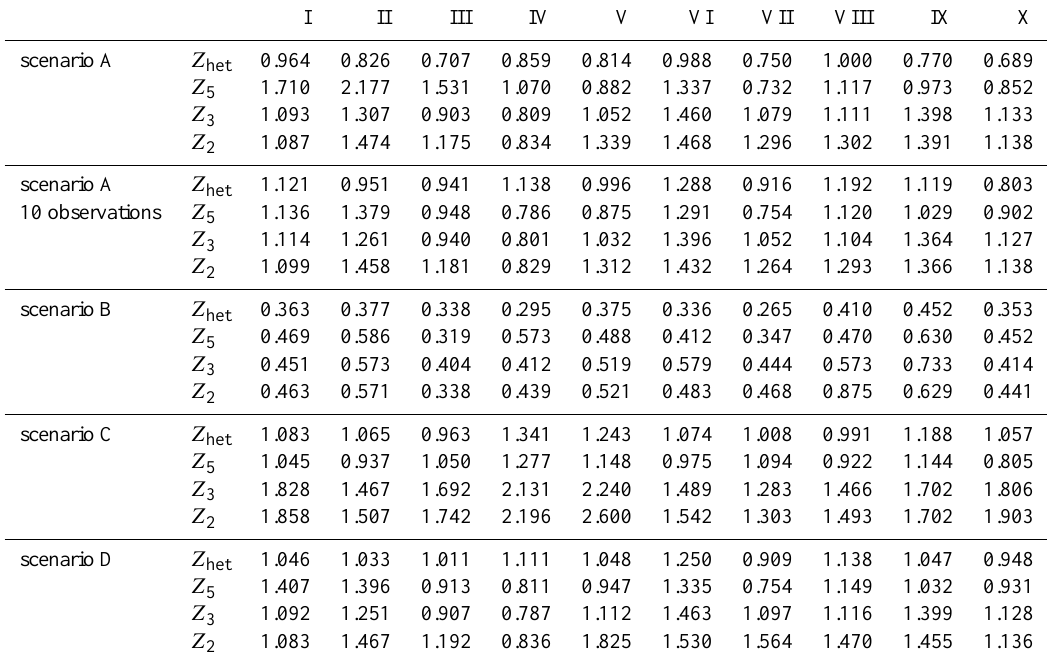
Table 4. Root mean square error of mean leakage coefficients log 10 (L ∗ ) in [log 10 (ms − 1 )] at the end of the simulation period. Results are shown for all scenarios and references.